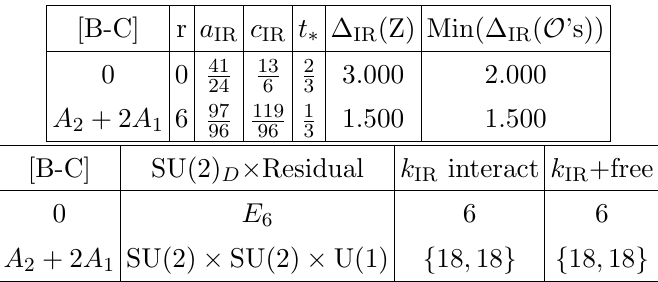
Table 11. Plain nilpotent mass deformations of the Minahan-Nemeschansky theory with E 6 (cid:13)avor. The top table has the central charges a IR and c IR as well as scaling dimensions while the table below contains the information about the (cid:13)avor central charges.